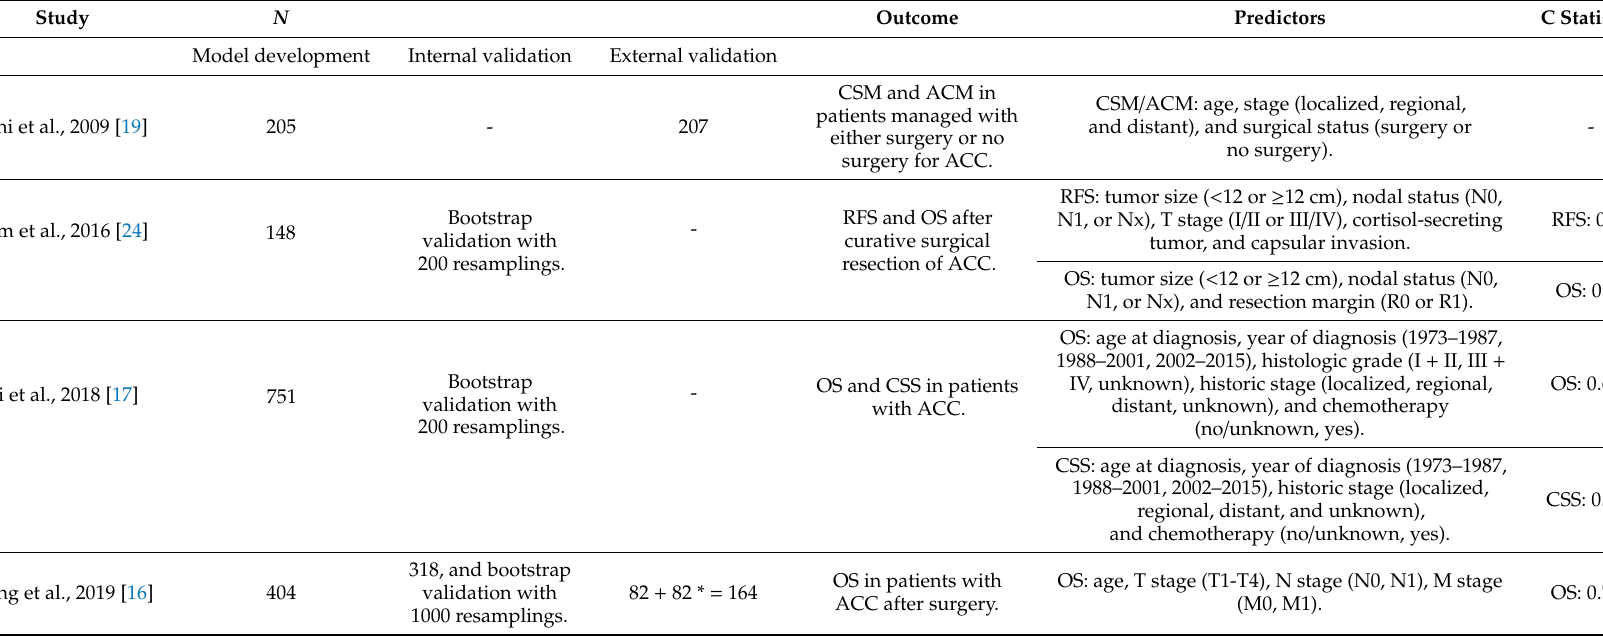
Table 3. Overview of current models for prognostication in patient with